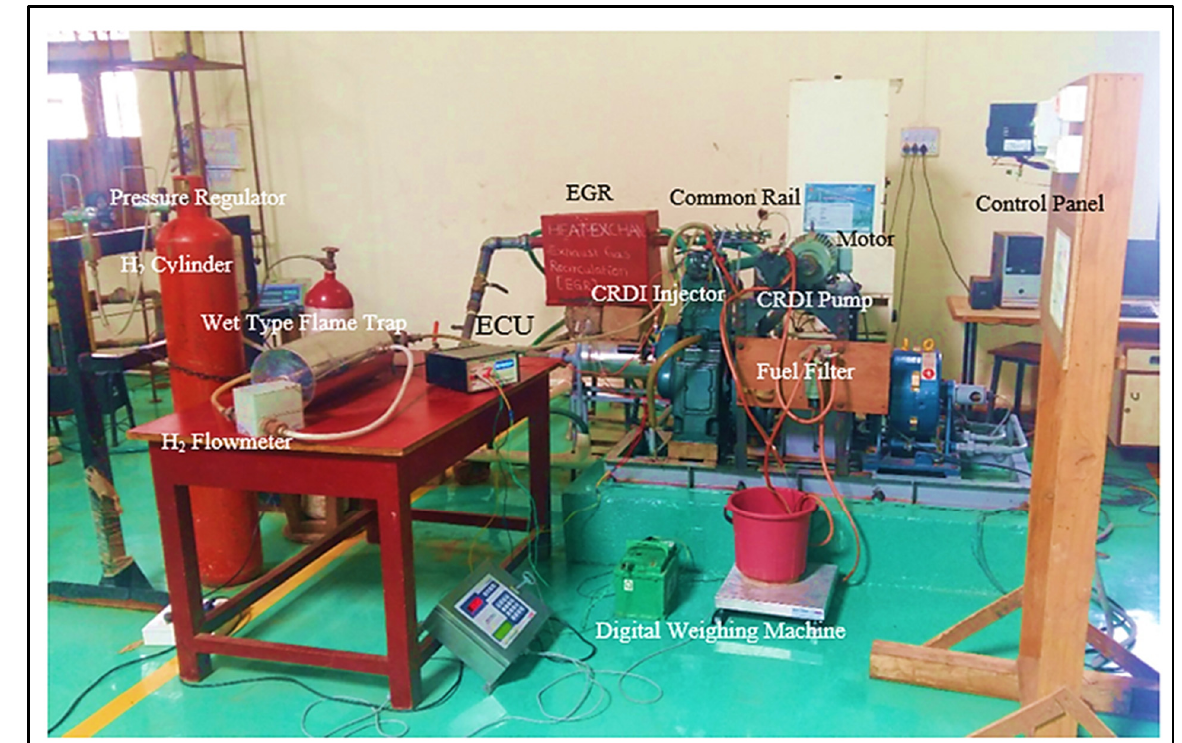
Figure 1. Layout of computerized CRDI diesel test engine.